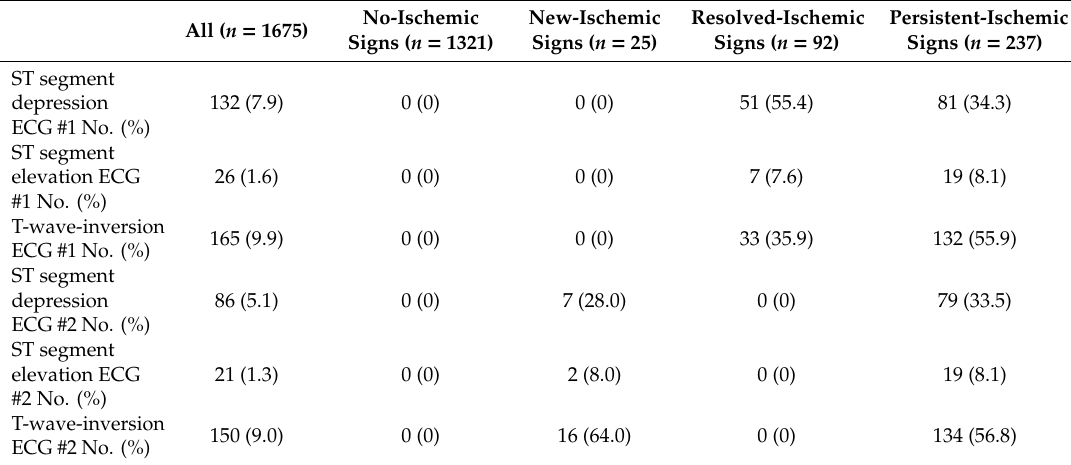
Table 2. Type of ischemic ECG findings for study population and each subgroup.